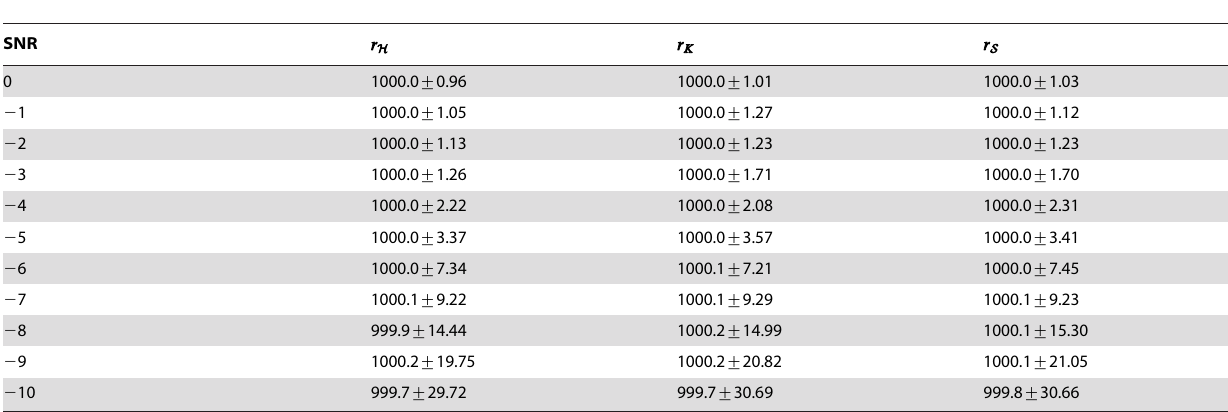
Table 5. Performance comparison of r H , r K and r S for y ½ i (cid:2) being a segment of sin wave.